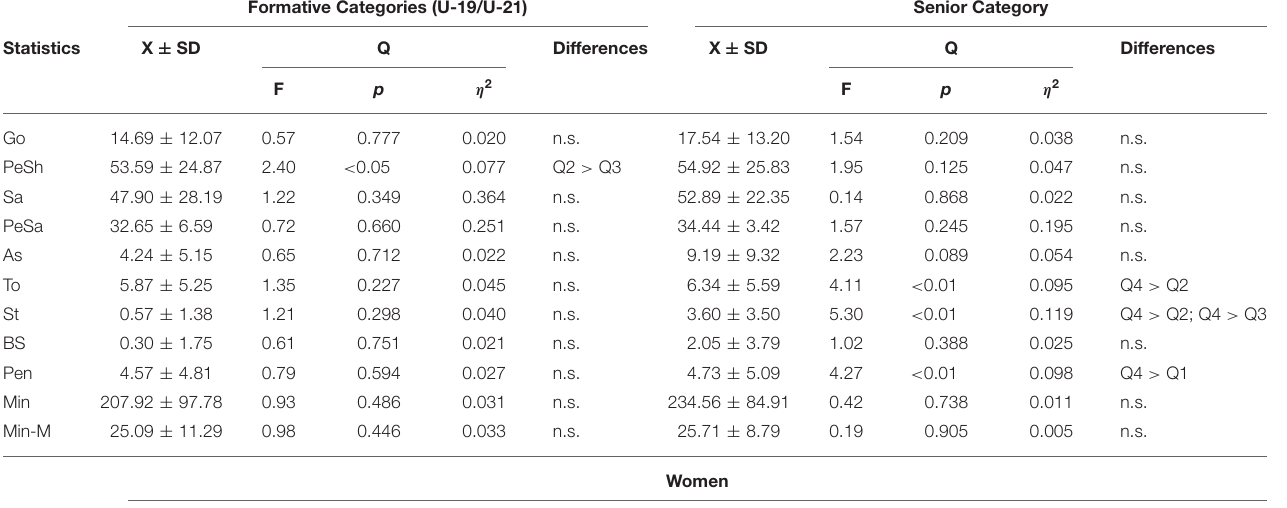
TABLE 3 | Impact of the birth quartile (Q) on individual performance statistics (X ± SD) in Spanish handball players.